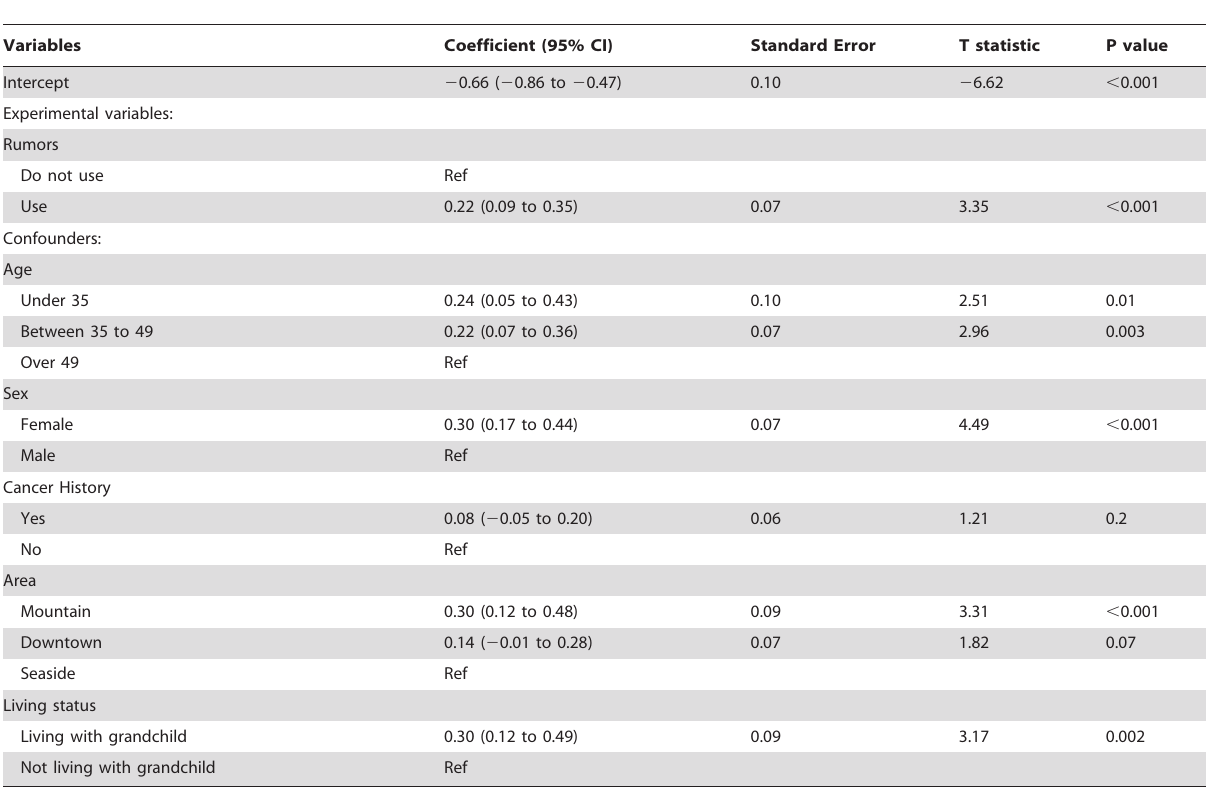
Table 3. Multiple regression model of factor one against the media variables.